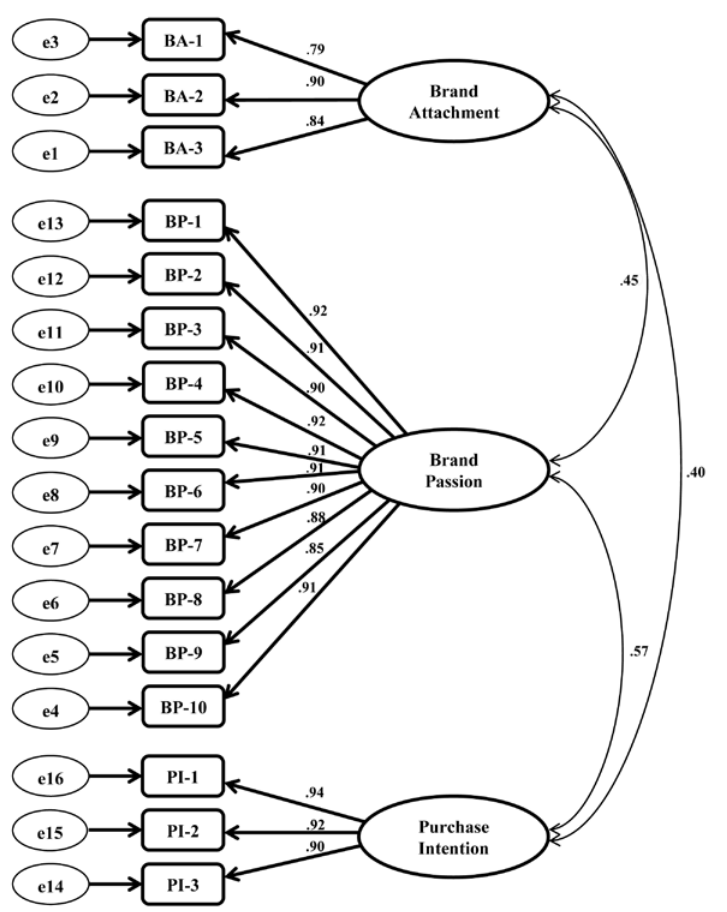
Figure 2. Confirmatory factor